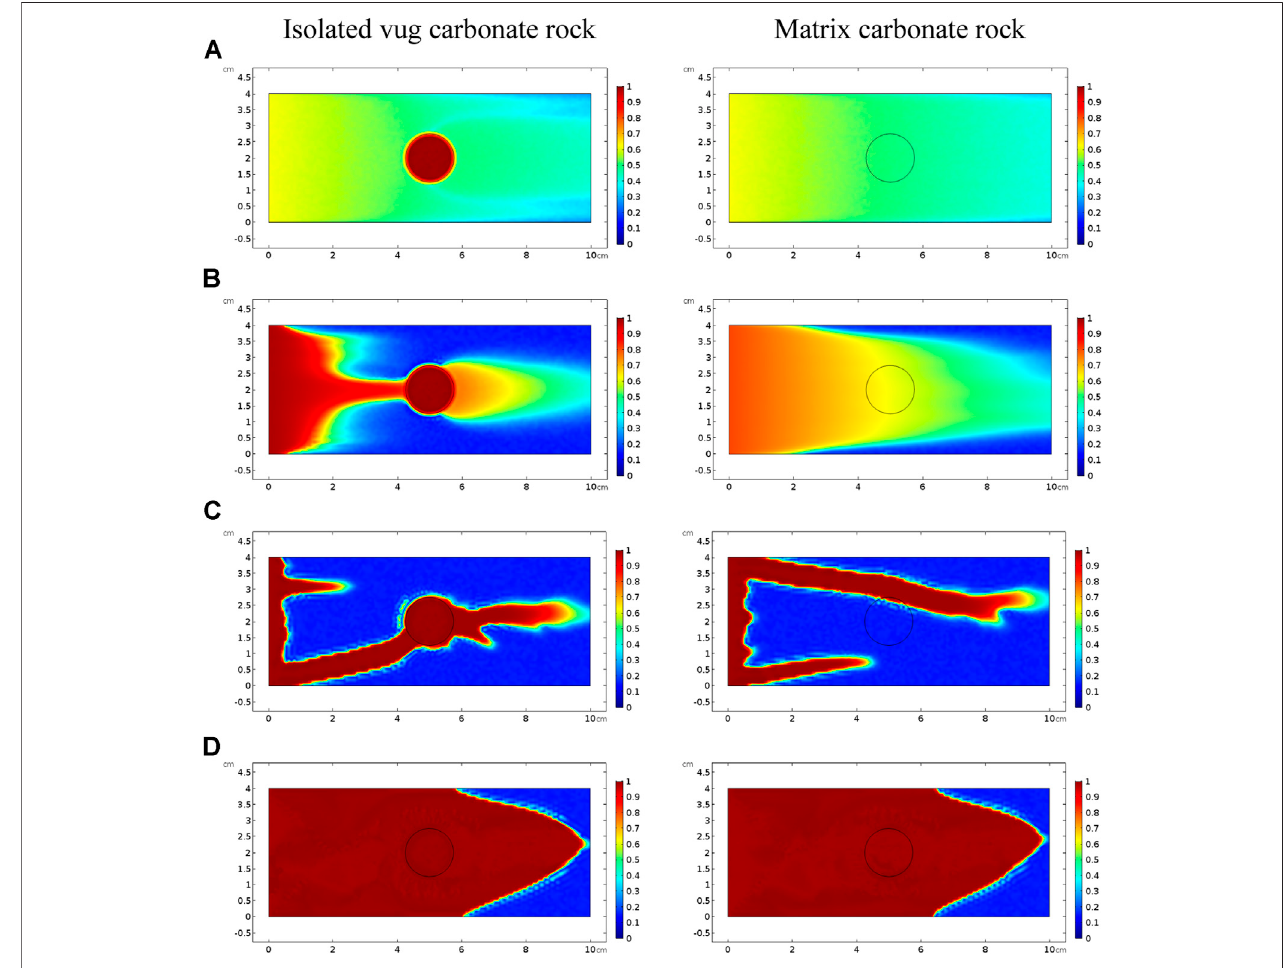
FIGURE 6 | Comparison of dissolution patterns with different acid injection velocities: (A) 0.5 cm/s, (B) 0.05 cm/s, (C) 0.005 cm/s, and (D) 0.0005 cm/s.